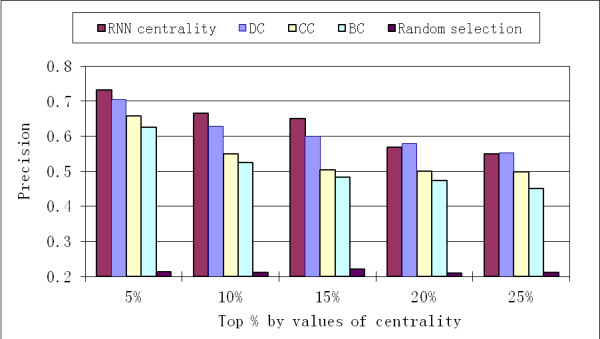
The proportion of essential proteins (precision) in proteins ranked by different centrality measures. RNN centrality is compared with DC (degree centrality), CC (closeness centrality), BC (betweenness centrality) and centrality based on random selection. Results were based on yeast HC PPI network. In each category, the top % of proteins with highest centrality values were computed by different methods and compared.